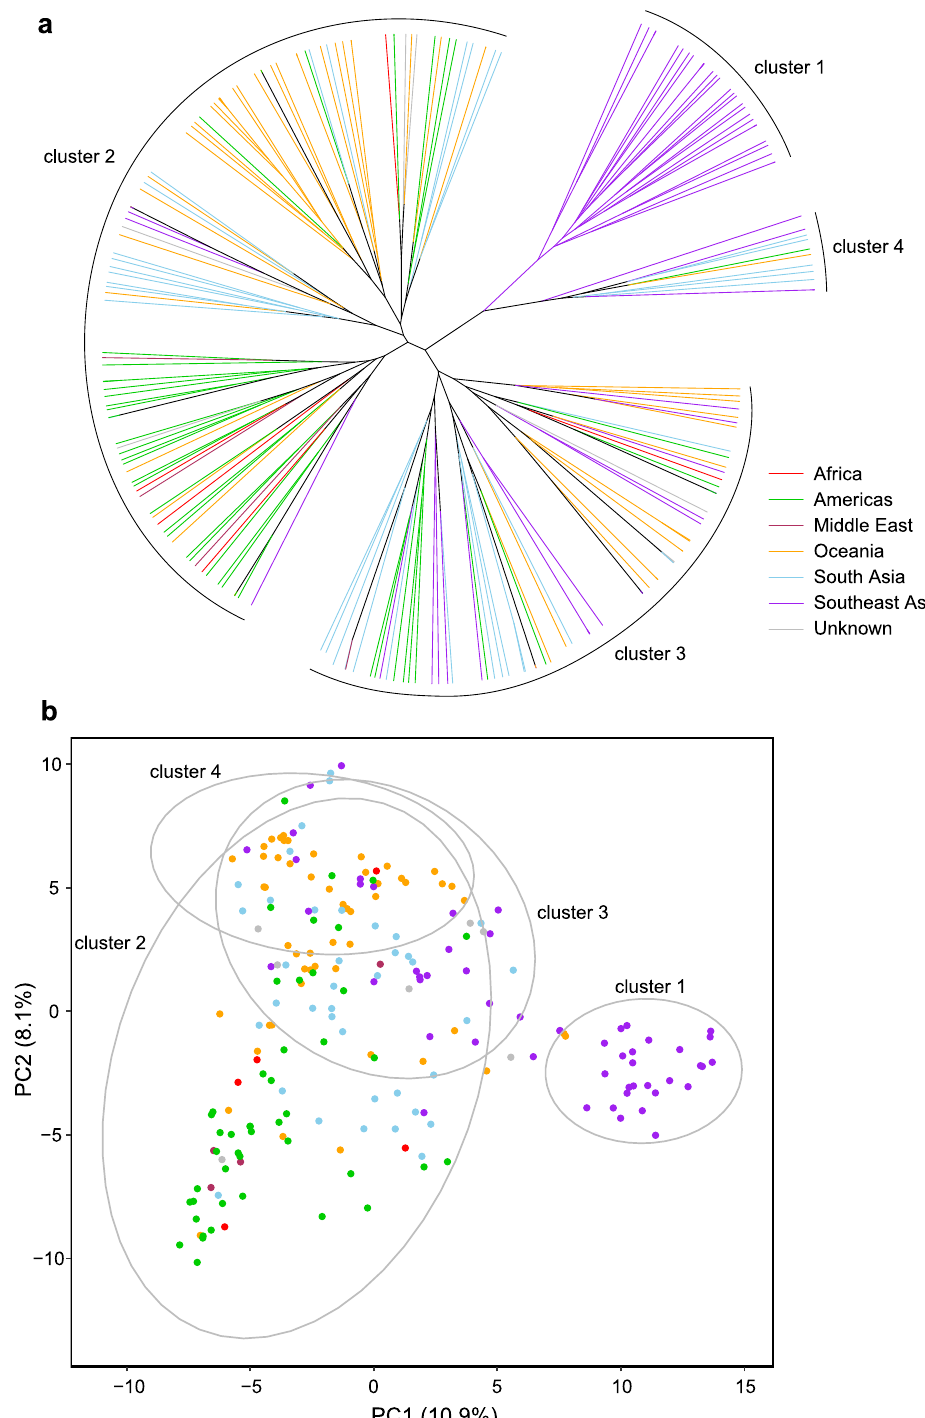
Figure 1. Genetic structure analyses for K = 4 of the 208 accessions of M. indica from six geographical regions across the world. ( a ) A circular dendrogram showing the hierarchical cluster analysis using complete linkage clustering. Each branch represents an individual with the colour of the branch representing the geographical region the sample was imported into Australia from. ( b ) Principal components analysis, where the ellipses (95% probability) represent the four clusters from the hierarchical cluster